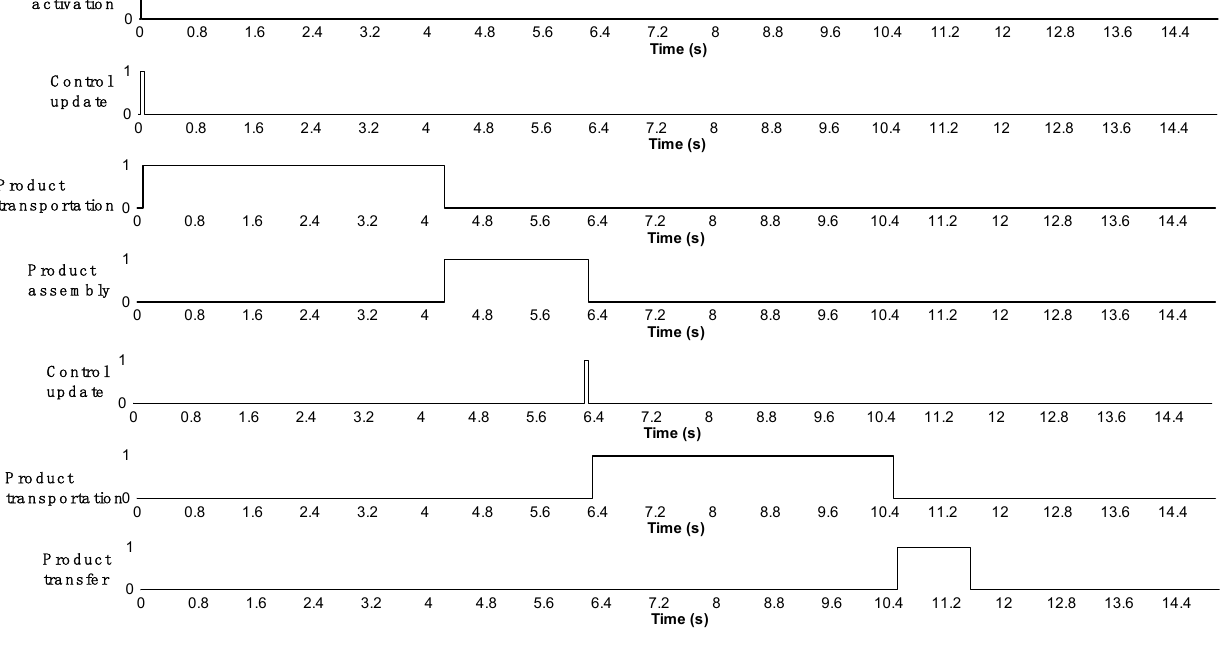
Figure 10. Model simulation duration results.